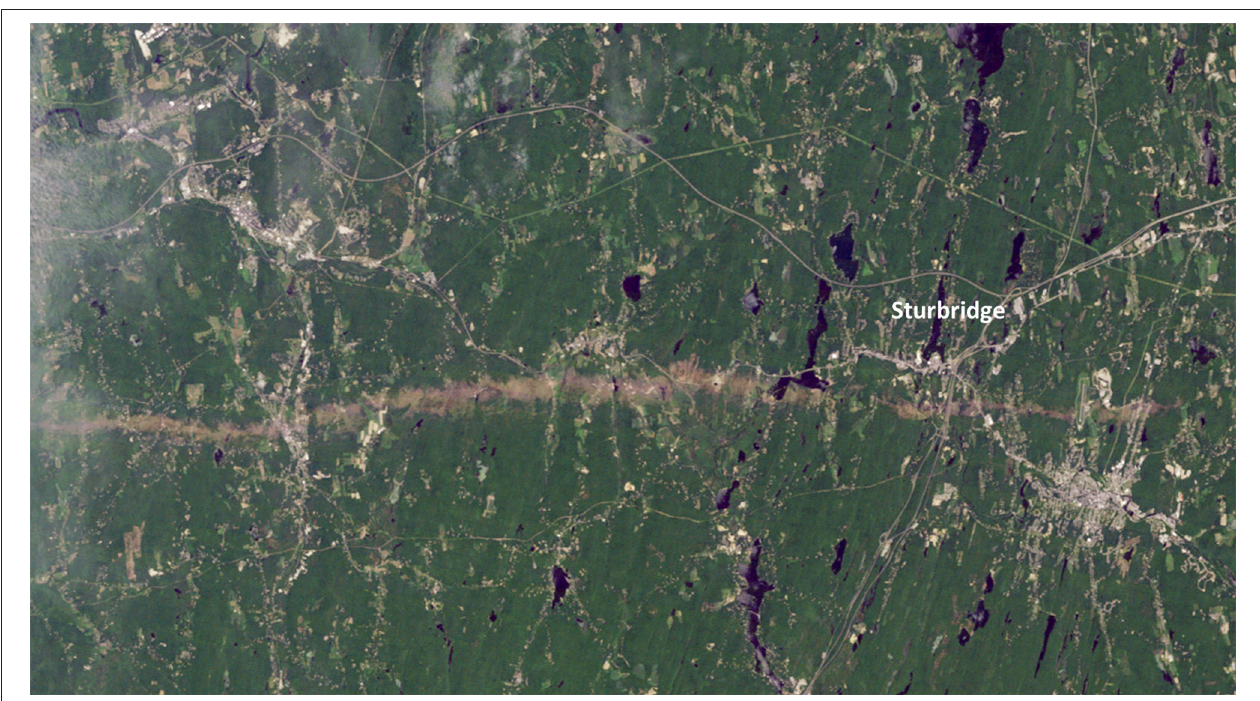
FIGURE 2 | Natural color image (30m) from Landsat 5 Thematic Mapper showing tornado track from June 1, 2011. The town of Sturbridge, MA, was struck by this EF3 tornado. Image acquired on June 5, 2011. Image credit: NASA (public domain).